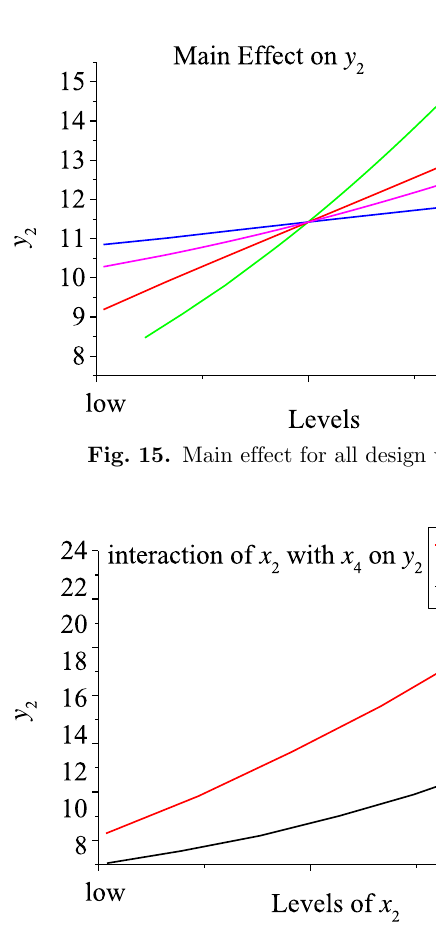
Fig. 16. Interaction effect between x 1 and x 2 .